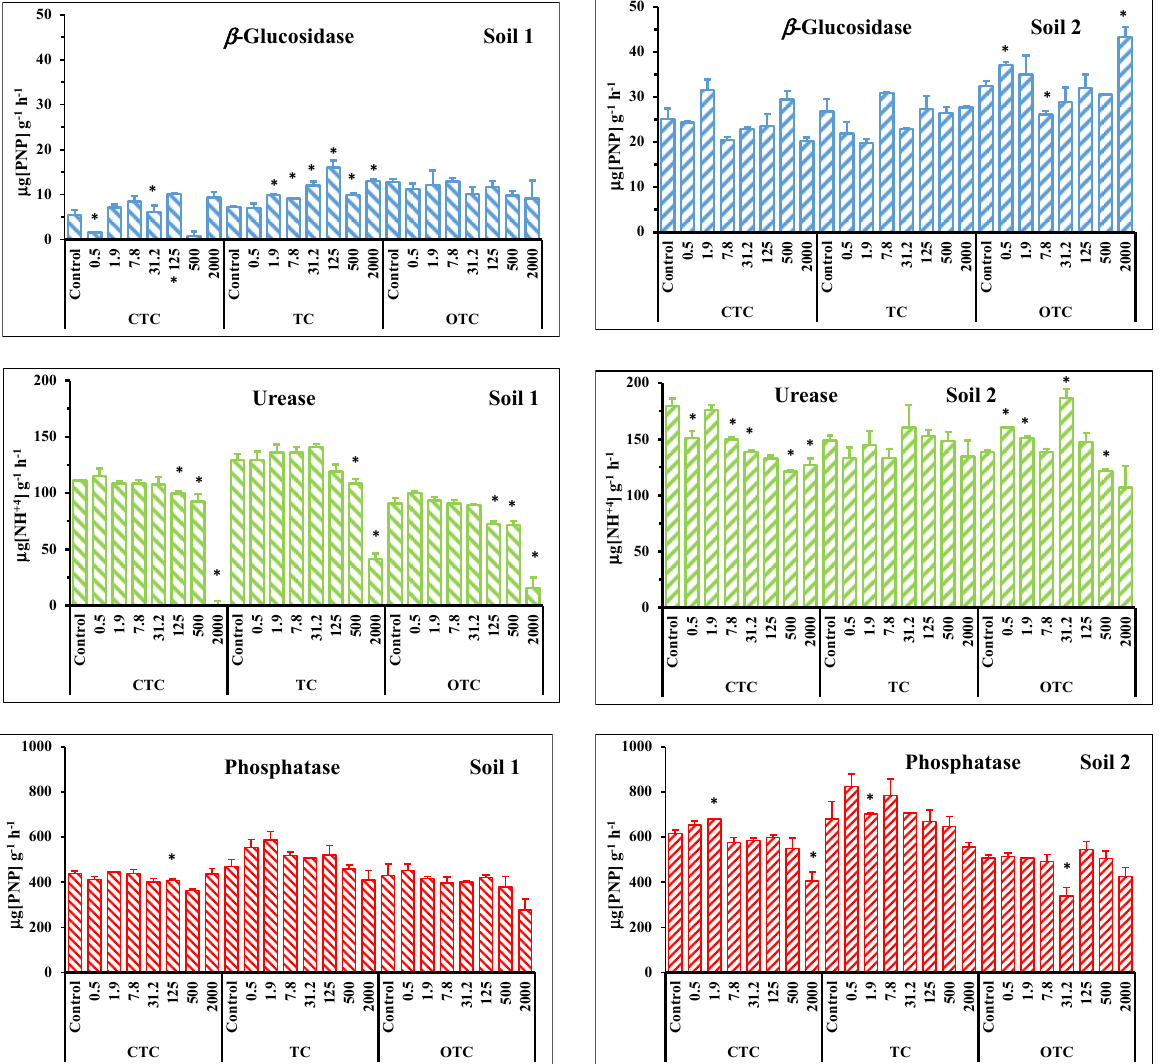
Figure 1. Soil enzymes in the four soils studied treated with different doses of the tetracycline antibiotics (CT chlortetracycline; TC, tetracycline; OTC, oxytetracycline) 42 days after application. Data are expressed per g of soil (absolute va- lues). The error bars represent the standard deviation ( n = 3). Asterisks (*) indicate a significant difference compared to the control without addition of antibiotics ( p < 0.05).